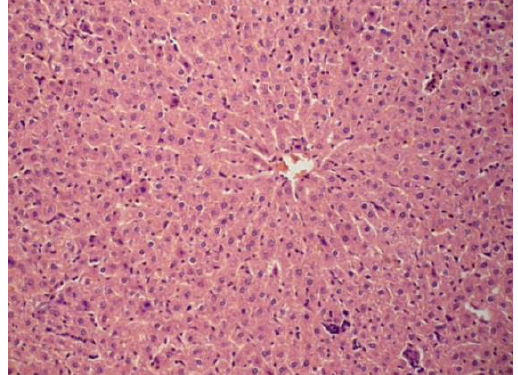
Fig. 12. SHR rat liver. Combined long-term therapy (candesartan and corvitin). Staining with hematoxylin and eosin. Eye. 10×. Lens.